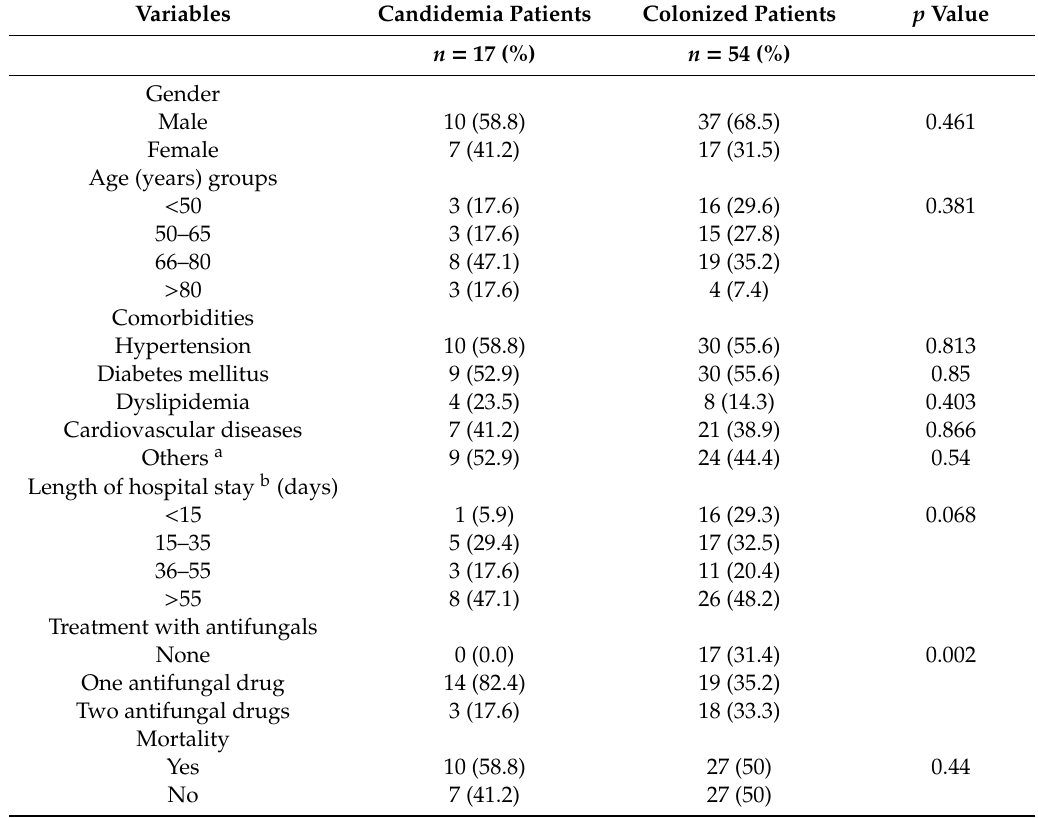
Table 1. Demographic and other characteristics of candidemia patients versus patients colonized with C.